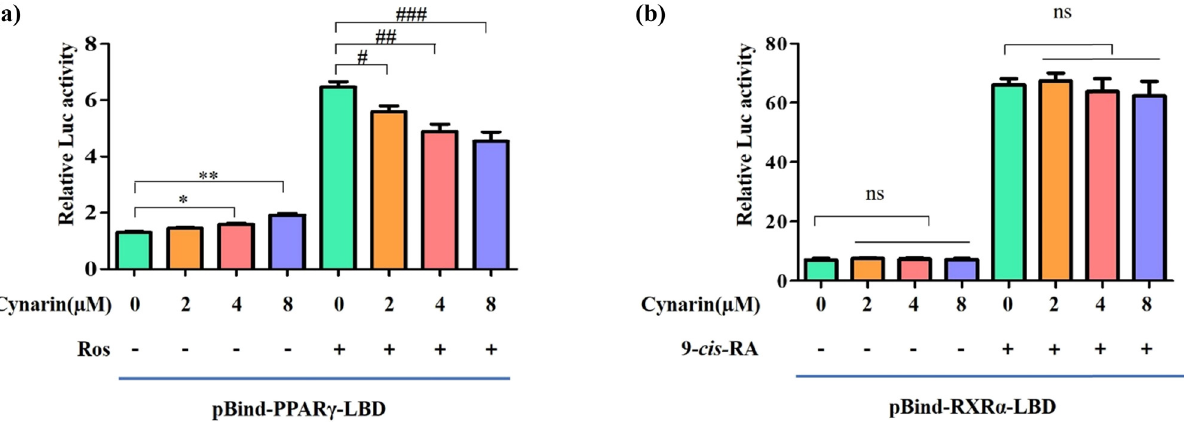
Figure 2: Cynarin is a selective partial agonist of PPAR γ . ( a ) The e ff ect of cynarin on PPAR γ transcriptional activity. ( b ) The e ff ect of cynarin on RXR α transcriptional activity. * p < 0.05 vs vehicle group, ** p < 0.01 vs vehicle group, # p < 0.05 vs ROS group, ## p < 0.01 vs ROS group, ### p < 0.001 vs ROS group, n = 3.